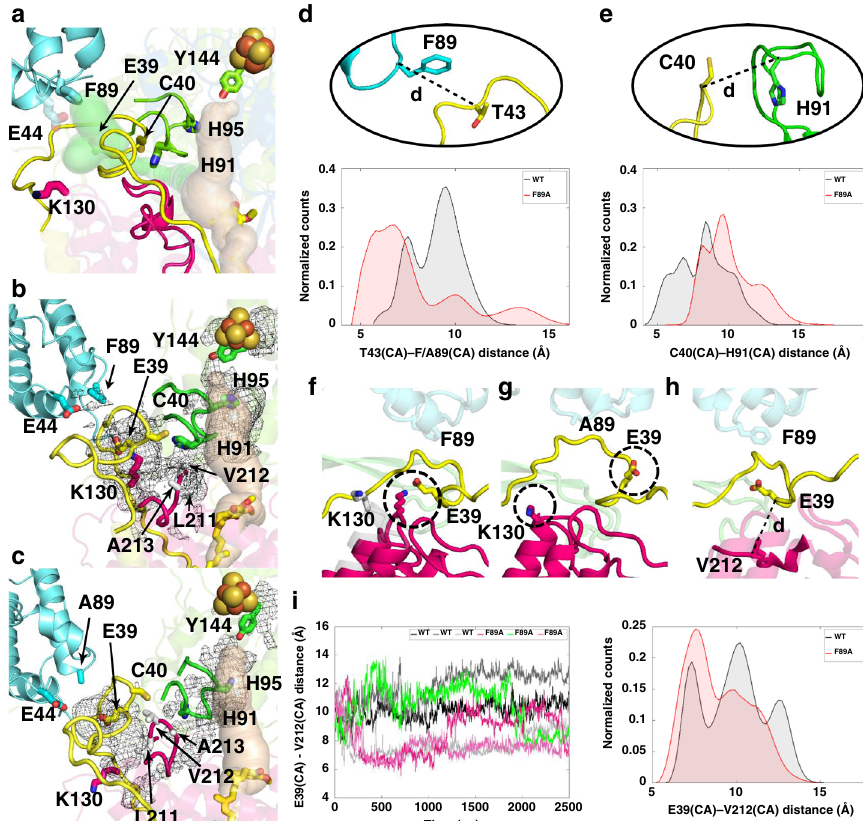
Fig. 3 Dynamics of key segments at the interface of ND3 and LYRM6 subunits. ( a ) shows the Q binding cavity (beige) and the tunnel identi fi ed (light green) in WT Y. lipolytica complex I structure (PDB 6RFR) using CAVER software 31 (radius 1.27 Å). Residue E44 LYRM6 highlights the entrance of the tunnel. Hydration of the proposed proton transfer path is shown by a dark gray mesh ( b ) calculated by averaging water occupancy in WT simulations. In contrast, in F89A LYRM6 mutant MD simulations, the hydrated path is blocked by conserved hydrophobic residues (L211 ND1 and V212 ND1 ) from the ND1 subunit ( c ) due to structural rearrangements. The absence of the bulky side chain in the F89A LYRM6 mutant causes instability in the ND3 segment and its displacement towards the LYRM6 segment ( d ), and away from the β 1- β 2 S2 loop ( e ). The selected distances are shown as histograms calculated from simulation trajectories. See also Supplementary Table 5 for similar data on complex I structures. The salt-bridge (K130 ND1 -E39 ND3 ) is stabilized in WT simulation ( f ) in contrast to F89A LYRM6 mutant simulations ( g ); gray, conformation of K130 ND1 in WT structure (PDB 6RFR). Shift of the short